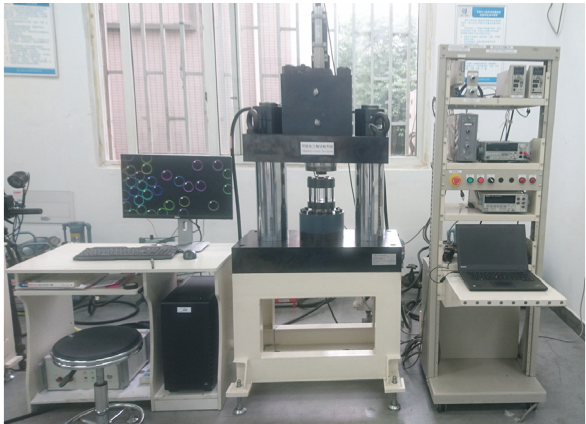
Figure 1: Servocontrolled test system for triaxial compression test.